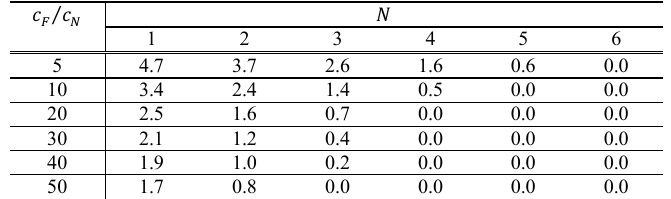
Table 4. Optimal 𝜆𝑇 0∗ when 𝜔𝐾 =